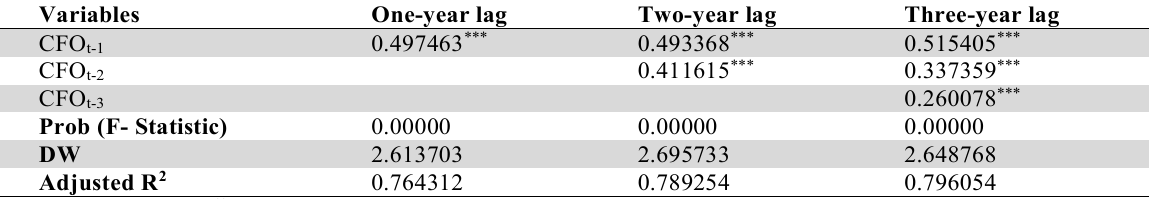
Summary of FEM regression results of the cash flow